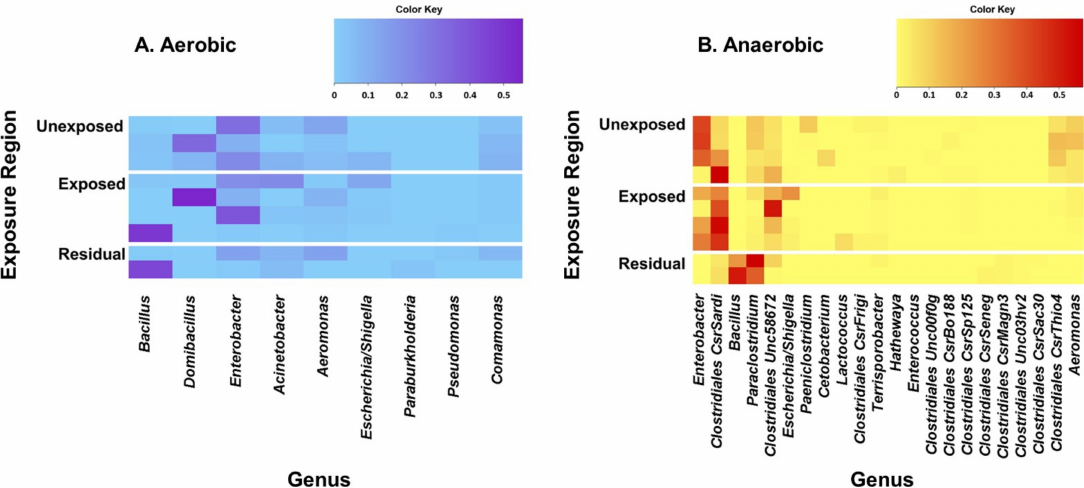
Figure 1. Heat maps of the predominant bacterial genera detected from the soil samples incubated under aerobic ( A ) and anaerobic ( B ) conditions. Pesticides-treated irrigated soil samples were collected from the unexposed, pesticide-exposed, and residual exposure areas and incubated for 24 h under aerobic and anaerobic conditions and analyzed for bacterial diversity. DNA was extracted and analyzed by 16S rRNA sequencing. Genera were excluded from the heat map if the greatest relative frequency among the samples was less than 0.5%. Obligate anaerobic genera were excluded from the aerobic heat map, and obligate aerobic genera were excluded from the anaerobic heat map. Genera were sorted by greatest sample-wide frequency to lowest sample-wide